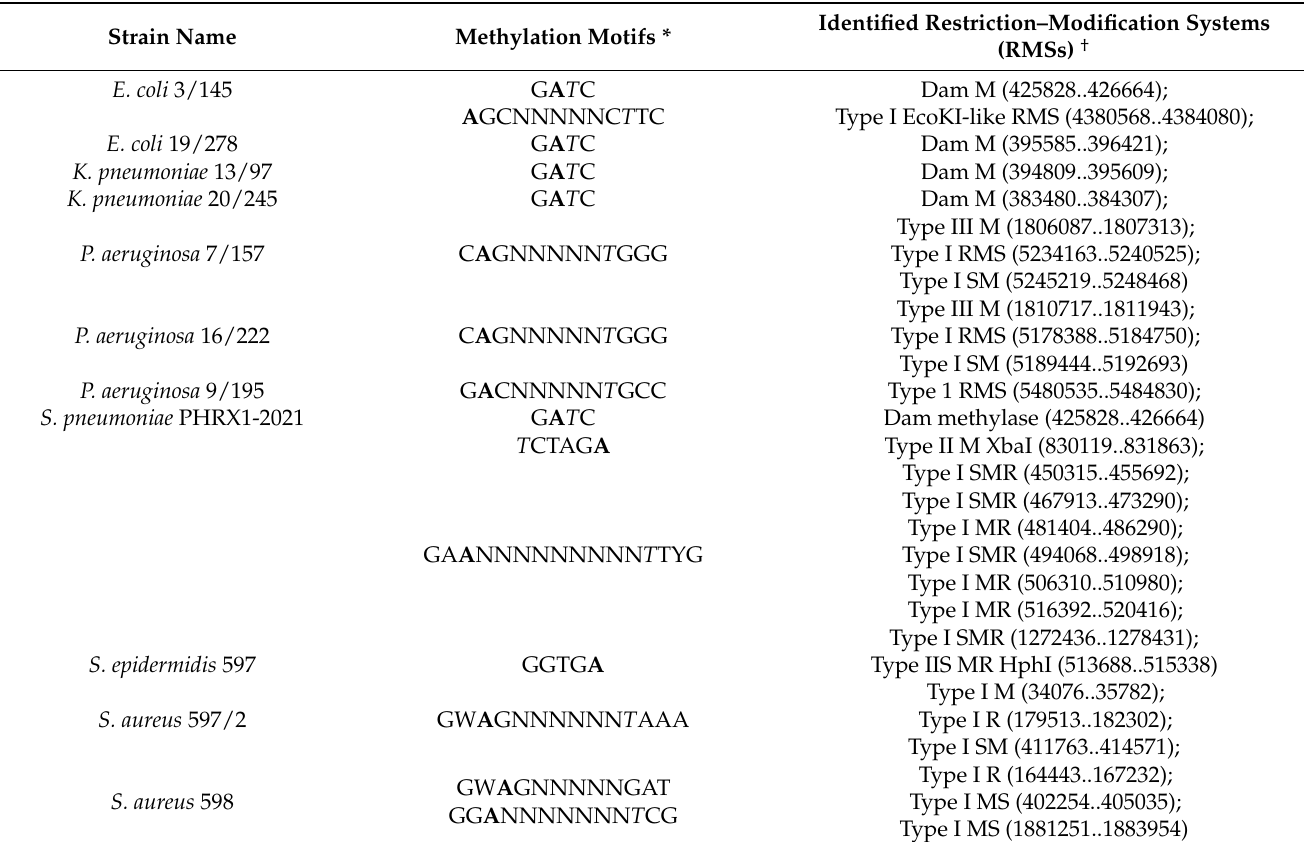
Table 5. Methylation motifs and associated restriction–modification